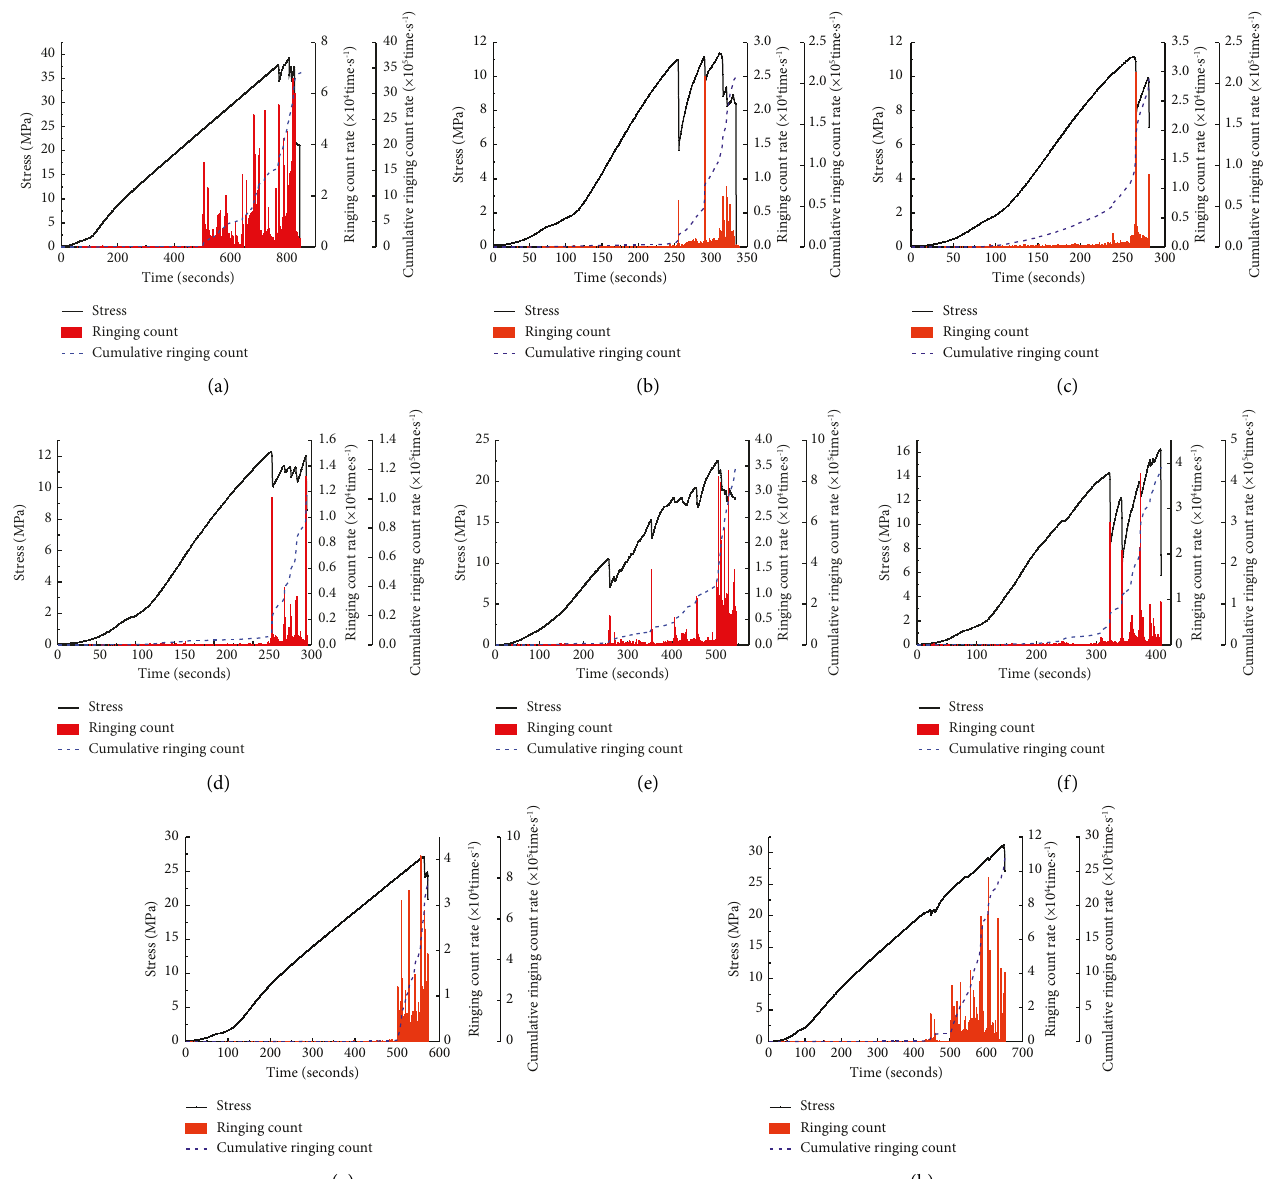
Figure 3: Acoustic emission ringing count rates and cumulative ringing count rates in fractured sandstones with different dip angles. (a) A- intact. (b) A-0. (c) A-15. (d) A-30. (e) A-45. (f) A-60. (g) A-75. (h)